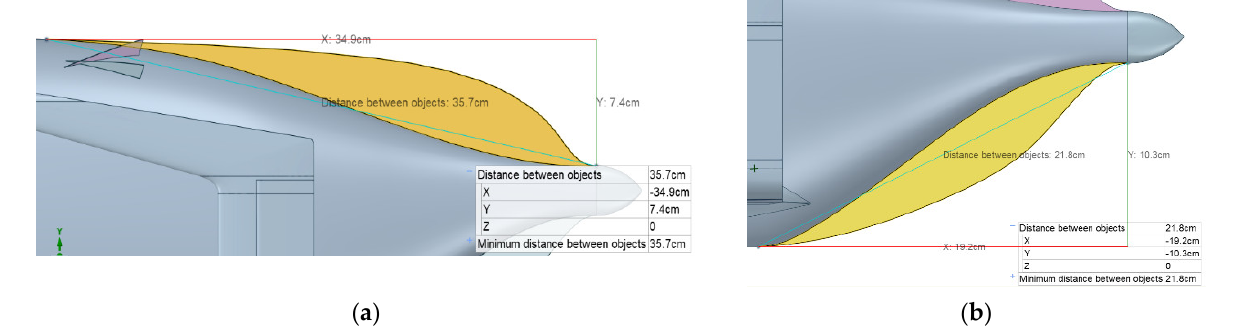
Figure 4. Dimensions of the large configuration “L” of vertical fins: ( a ) upper portion of the “L” fin, ( b ) ventral part of the “L” fin.